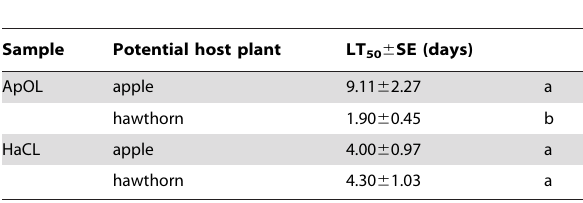
Table 3. Survival of remigrant Cacopsylla melanoneura females of the two samples on the potential host plants.